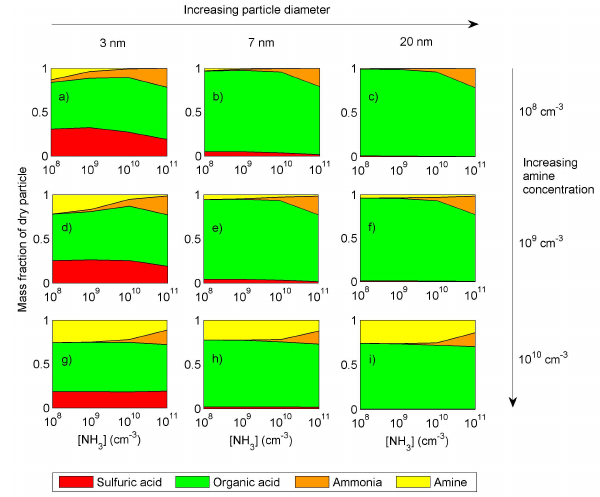
Fig. 4. Dry particle mass fractions of particles at 3nm (a, d, g) , 7nm (b, e, h) and 20nm (c, f, i) as a function of ammonia concentration at amine concentrations of 10 8 cm − 3 (a, b, c) , 10 9 cm − 3 (d, e, f) and 10 10 cm − 3 (g, h, i) . Concentration and saturation vapour pres- sure of organic acid were set to 3 × 10 8 cm − 3 and 10 − 6 Pa. Other properties of organic acid were as for organic acid 1 (Table 1). Sul- furic acid concentration (10 6 cm − 3 ) , RH (40%) and temperature (283.15K) were set to base case values in all simulations (Table